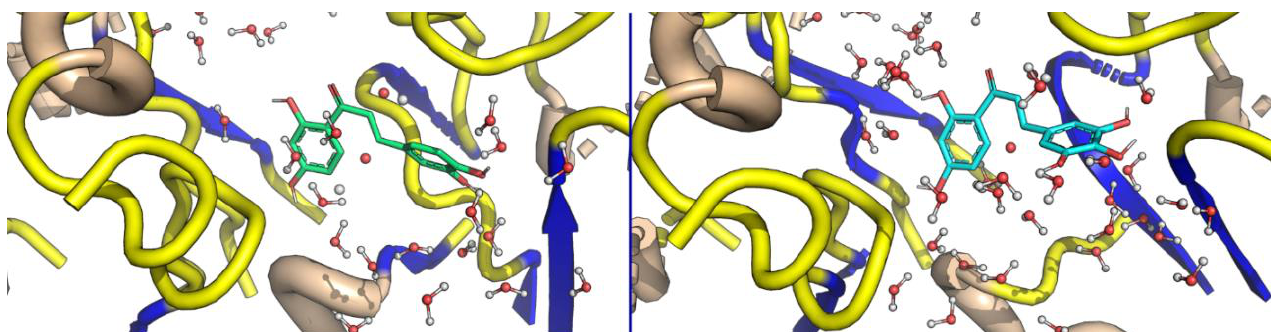
Figure 6. The solvated protein (left) and solvated binding pocket before interaction with the ligand (right).